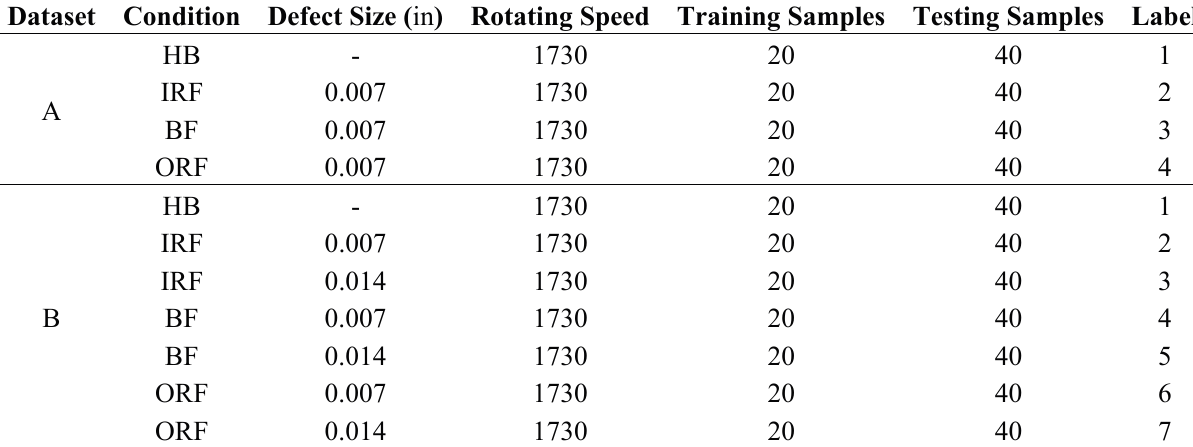
Table 1. Detailed specifics of REB fault datasets A and